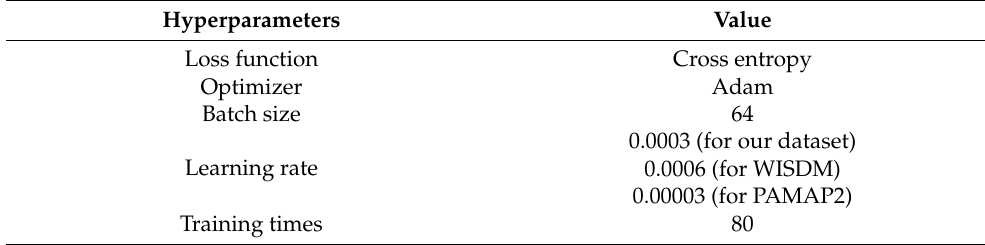
Table 2. Hyperparameters of the model